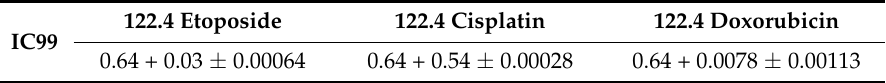
Table 2. The inhibitory concentration 99 (IC99) of drug combinations on BS-24-1 cells. A final concentration of 0.64 µ g/mL of 122.4 (equal to IC5 of 122.4) was needed in a combination with the IC5, IC80 and IC10 of cisplatin, etoposide, doxorubicin, respectively. Data shown are pooled results of minimum of three experiments using ComboSyn. IC5 calculation was performed using the linear regression line equation.